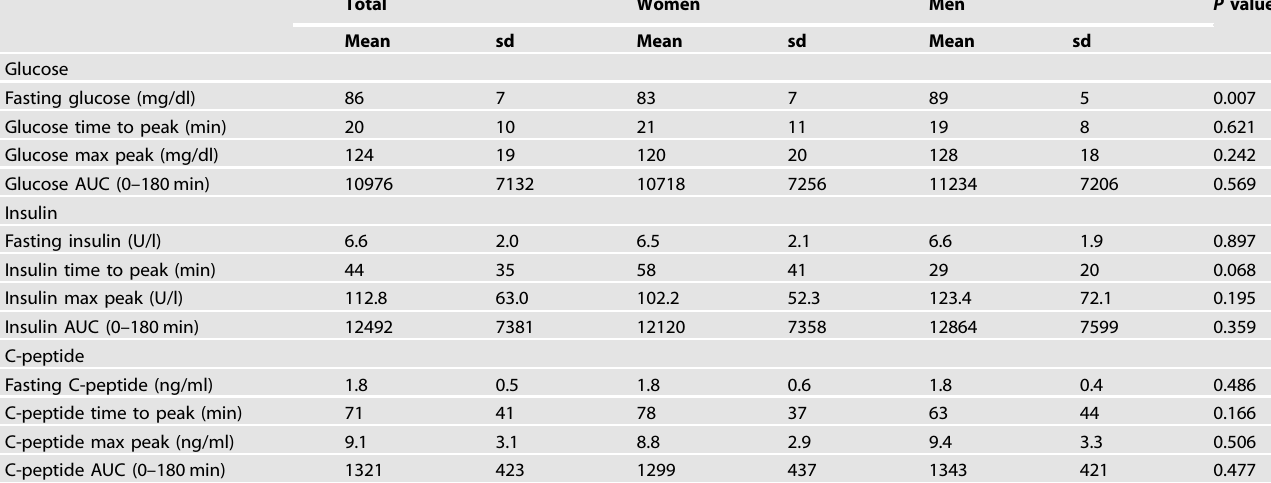
Table 4. Hormone and glucose concentrations at baseline and parameters of postprandial glycemic response.